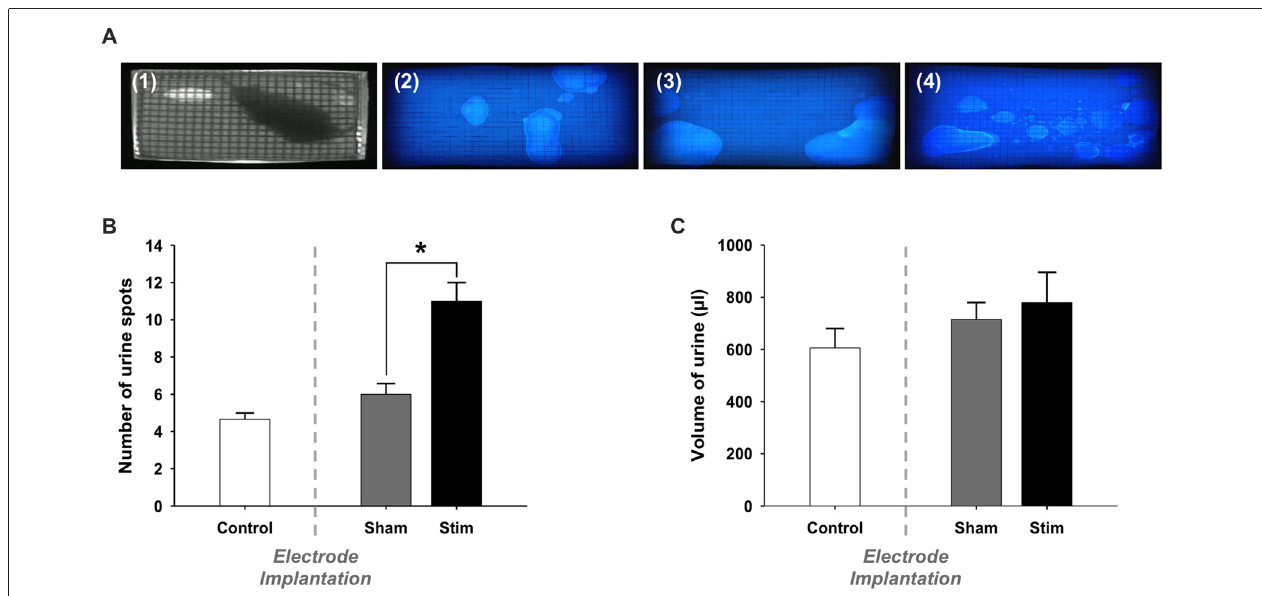
FIGURE 2 | Voiding behavior: Voiding parameters. (A) Representative photographs of (1) an extract from the video recorded during a voiding behavior task (VBT) and filter papers from the same rat (2) before the surgery (Control), (3) after the electrode implantation (Sham) and (4) during electrical stimulation of the bladder (Stim). (B) Number of urine spots. During the stimulation, rats voided more frequently than when the stimulation was switched-off. Values are represented as means ± SEM. Control n = 5, Sham n = 5 and Stim n = 5. t -test, Sham vs. Stim, ∗ p < 0.05. (C) Total volume of voided urine. The total volume of urine spots was not significantly larger in stimulated condition compared to sham and control